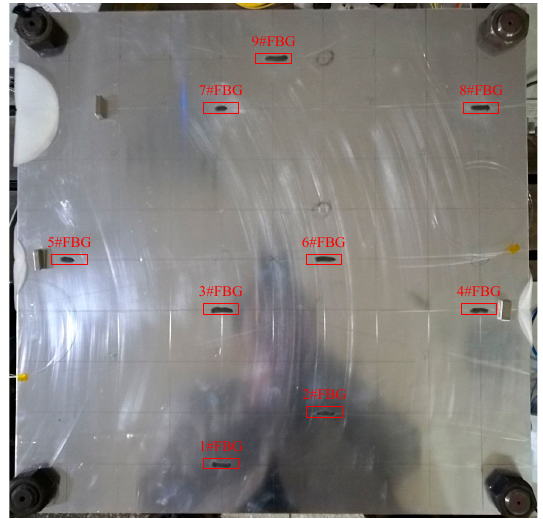
Figure 6. Experimental FBG sensor placement.